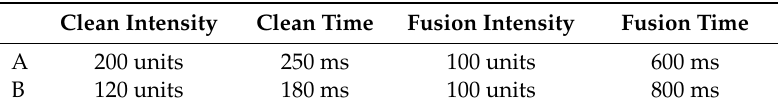
Figure 4. The schematic of the fabrication process. ( a ) Well-cleaved the SMF and silica casing. ( b ) Fusing the SMF and silica casing together at the end of the silica casing. ( c ) Cleaved the silica casing. ( d ) Well-cleaved the HST. ( e ) Fusing the silica casing and HST together at the other end of the silica casing. ( f ) Cleaved the excess of the HST. Table 2. Fusion